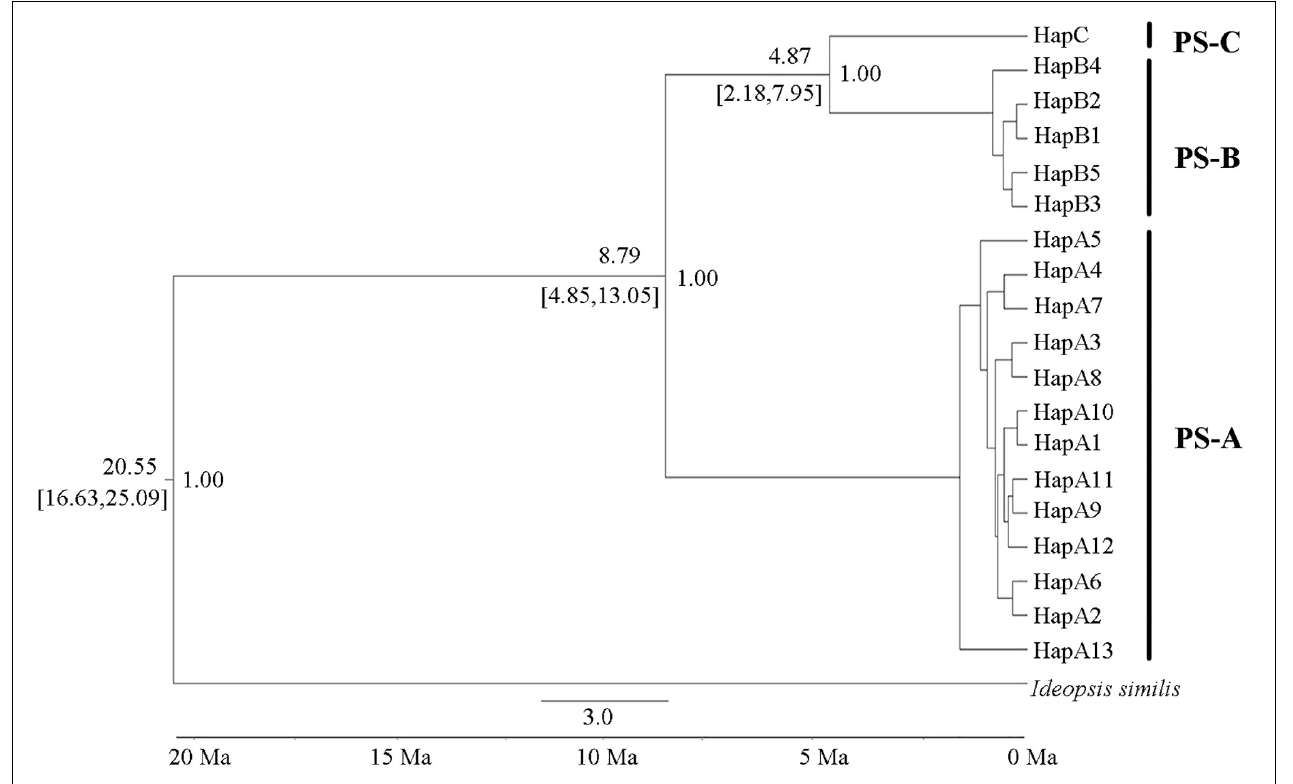
FIGURE 6 | Divergence time estimates of the three Parantica sita lineages (PS-A, PS-B, and PS-C). The number above a branch at the left of a node is the divergence time, and that below the branch is its 95% confidence interval. The number to the right of a node is the posterior probability. Ma: million years ago.